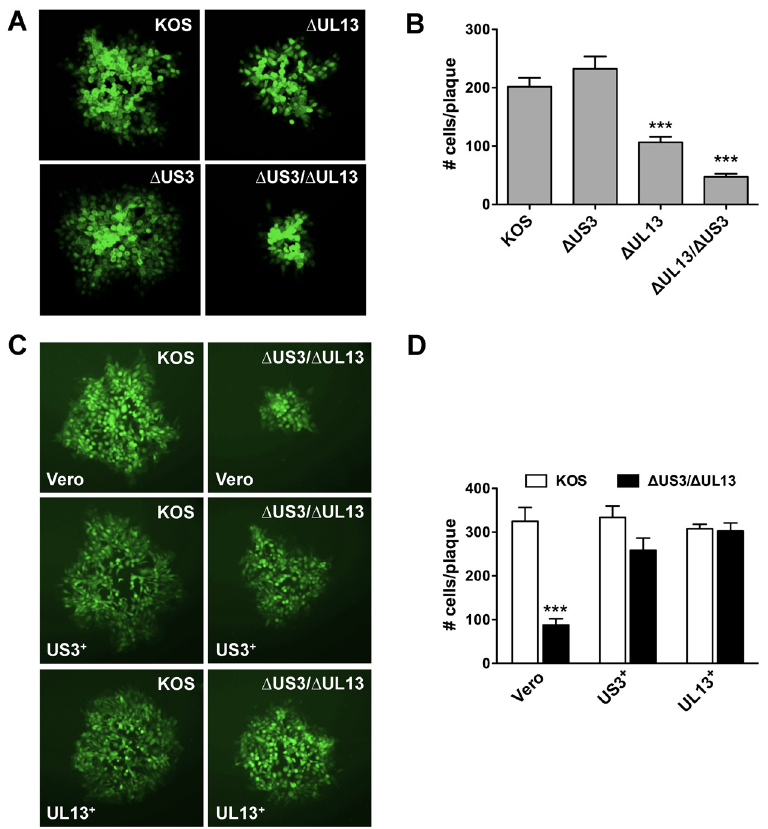
cells were inoculated with 300 pfu of HSV-1 KOS or HSV-1 kinase mutants. At 48 (A) and 60 (C) hours post- inoculation, the monolayers were fixed and labeled with FITC-conjugated anti-HSV-1 antibody. Representative plaques are shown at magnification of 100×. (B) and (D) Ten plaques in each infection were photographed, and infected cells were enumerated. Results are presented as the mean number of infected cells per plaque ± sem (n = 10 plaques; *** — p <